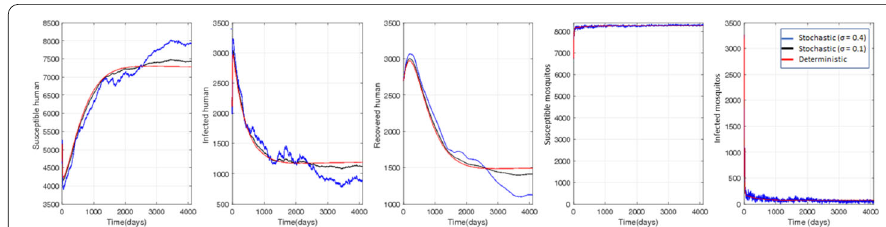
Figure 6 Model simulation with fumigation and without bed nets when R 0 > 1